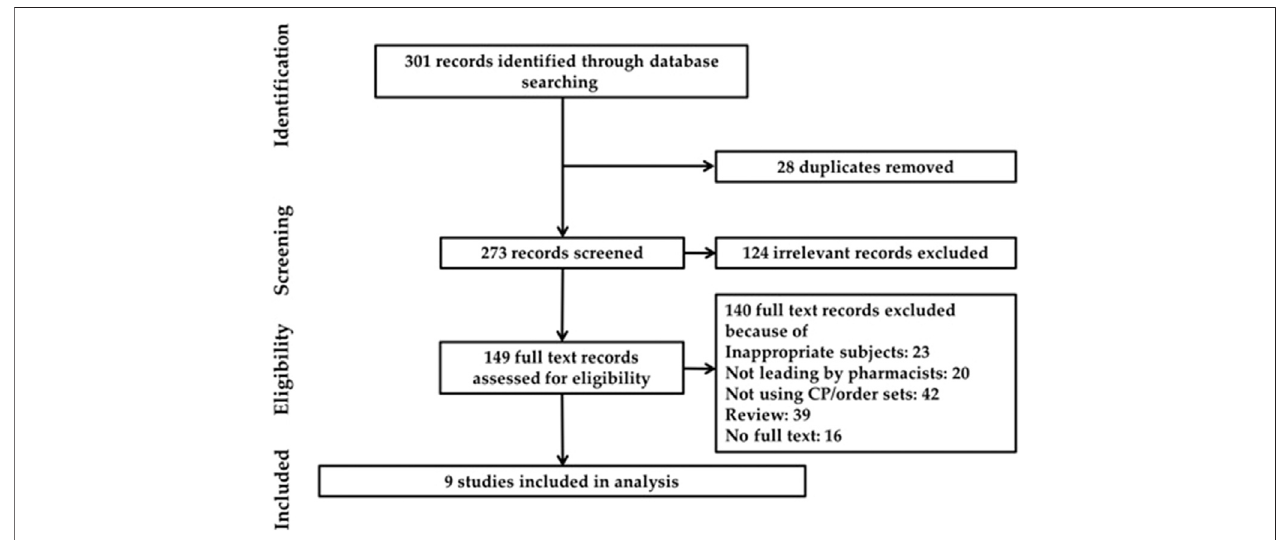
FIGURE 1 | Flowchart illustrating the selection process of studied